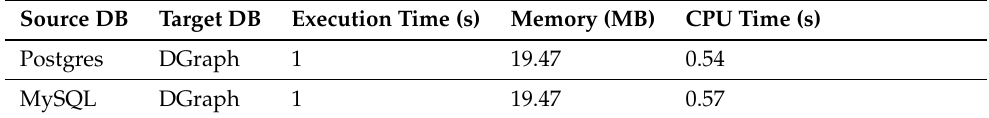
Table 4. Migration process evaluation for the migration scenarios Postgres ⇒ Dgraph and MySQL ⇒ Dgraph. Postgres and MySQL are both source